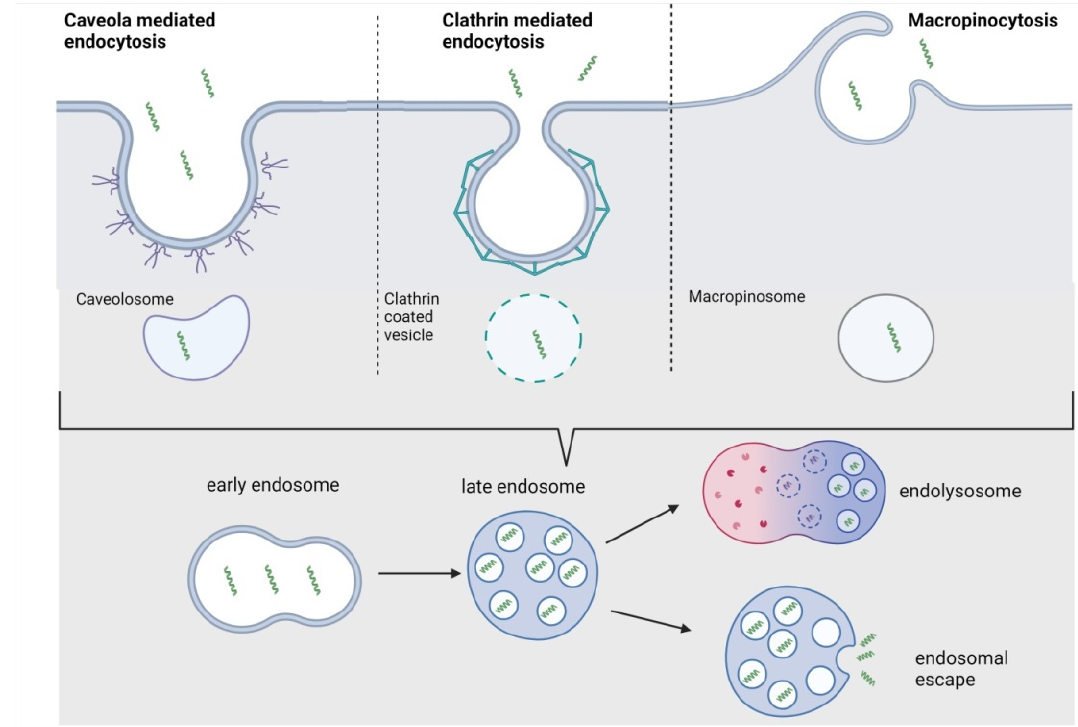
Figure 2. Different mechanisms of